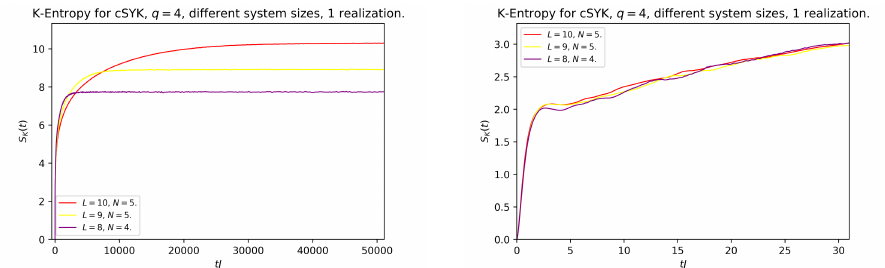
Figure 7 . Comparison of results for K-entropy for L = 8 , 9 , 10 ; for long time scales (left panel), and for early times (right